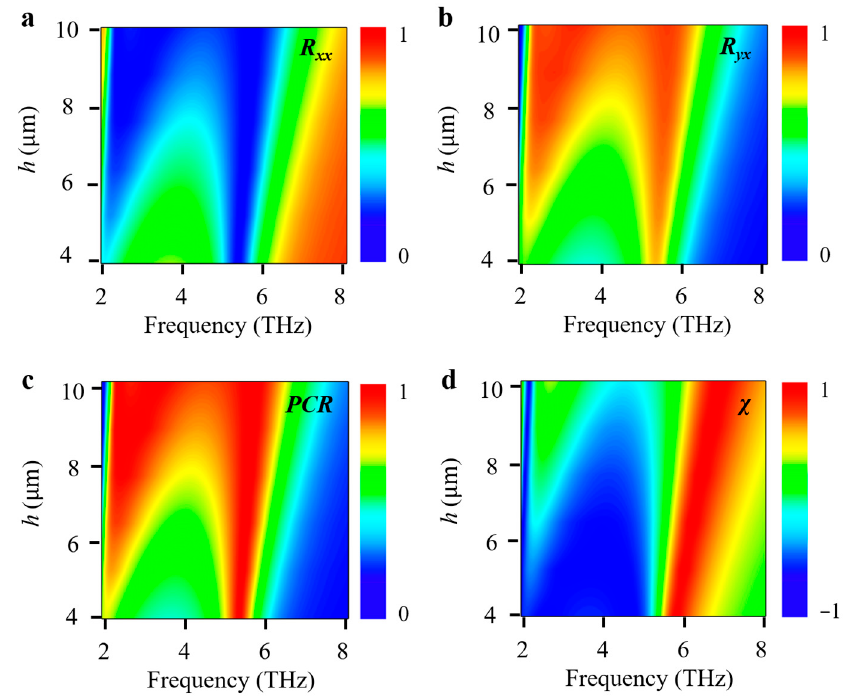
Figure 7. ( a , b ) The spectra of reflection coefficients for forward illuminated x -polarized light for various height h . ( c ) The calculated PCR ( x ) spectra, and ( d ) ellipticity spectra of x -polarized light for various height h . VO 2 is in the metallic state.